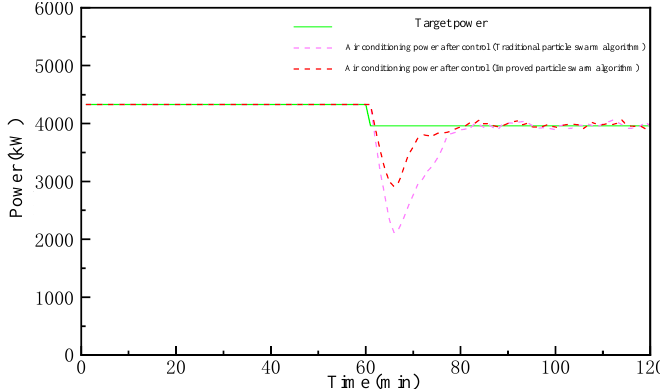
Figure 8. Simulation results of control strategy example.